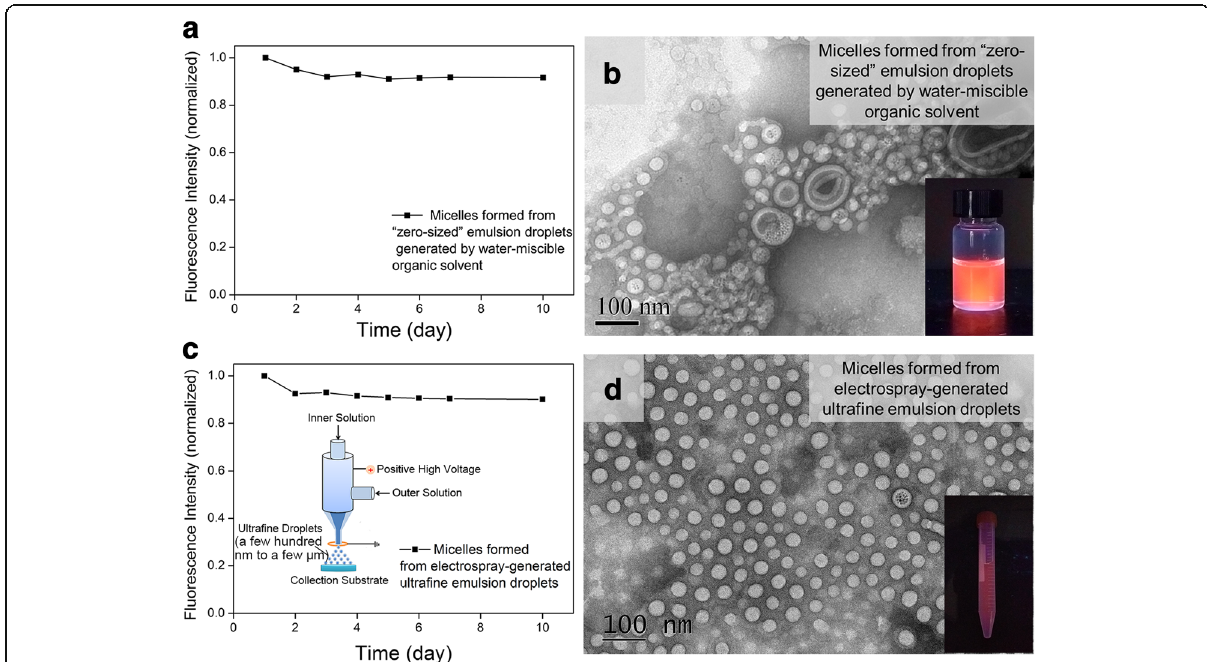
Fig. 4 Using additional methods to form small emulsion droplets to confirm the importance of droplet size. a , b Using water-miscible THF as the oil phase solvent (without using PVA) led to micellar QDs with stable fluorescence ( a ) and irregular micelle shapes ( b ). c , d Using electrospray (with PVA) to form droplets led to micellar QDs with stable fluorescence ( c ) and regular micelle shape ( d )